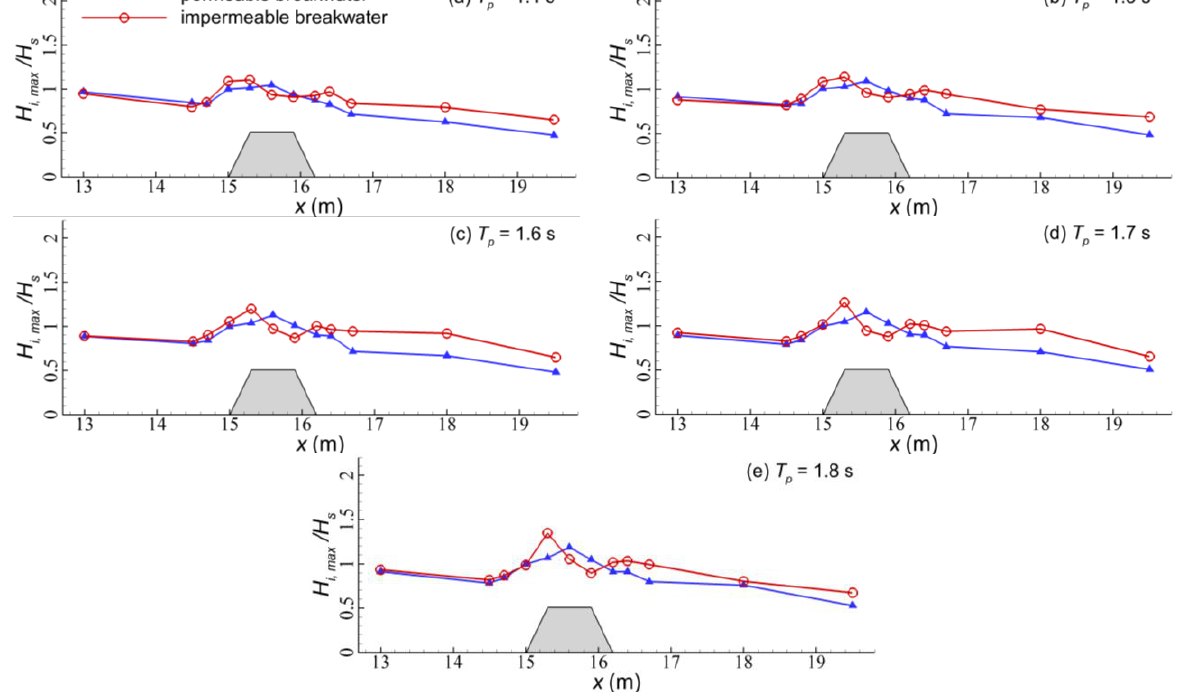
Figure 19. Spatial distribution of the maximum local wave heights with different peak wave periods;